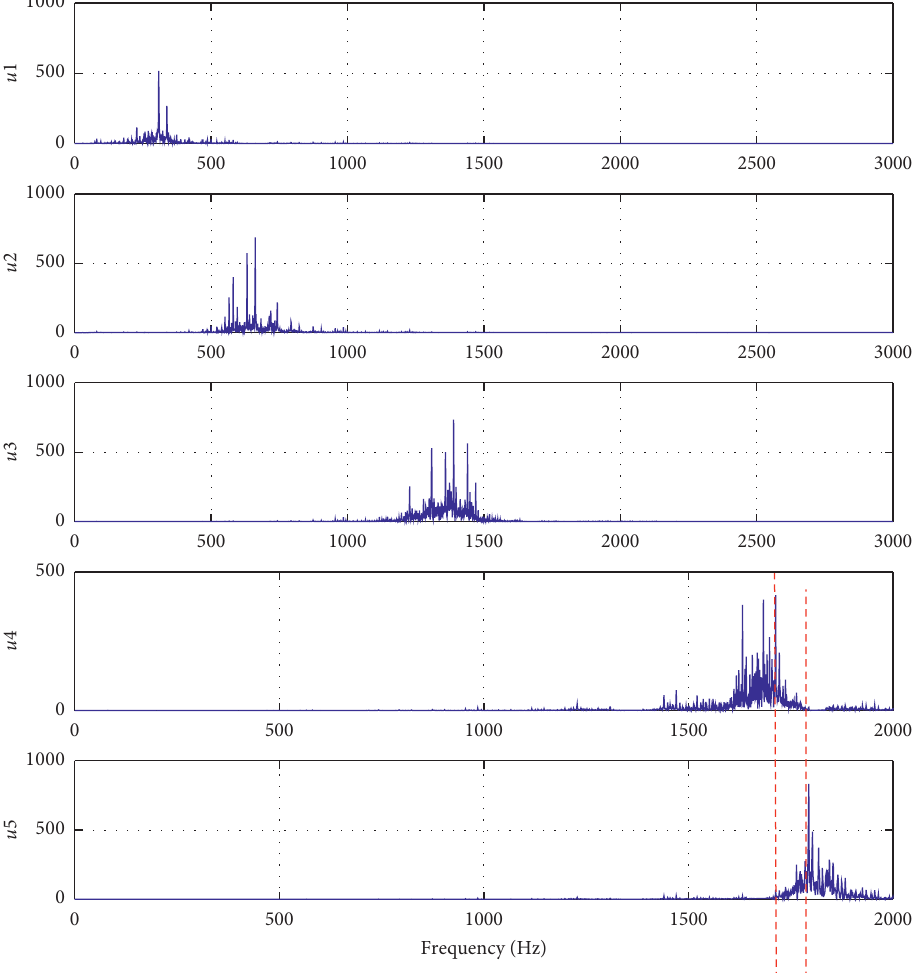
Figure 15: Spectrums of each mode decomposed by traditional VMD.